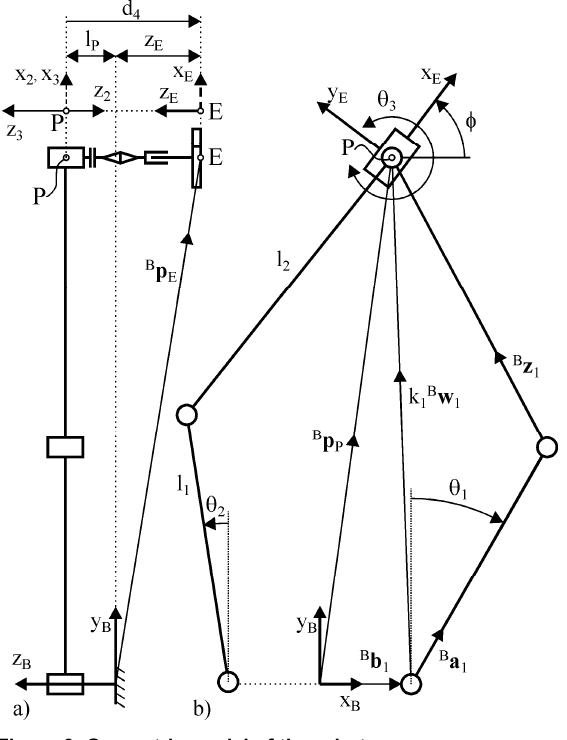
Figure 3. Geometric model of the robot